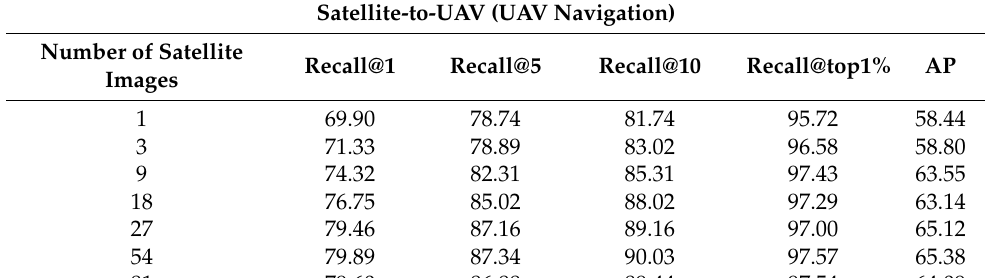
Table 4. The matching accuracy (%) of different numbers of satellite-view images of a target location in the training